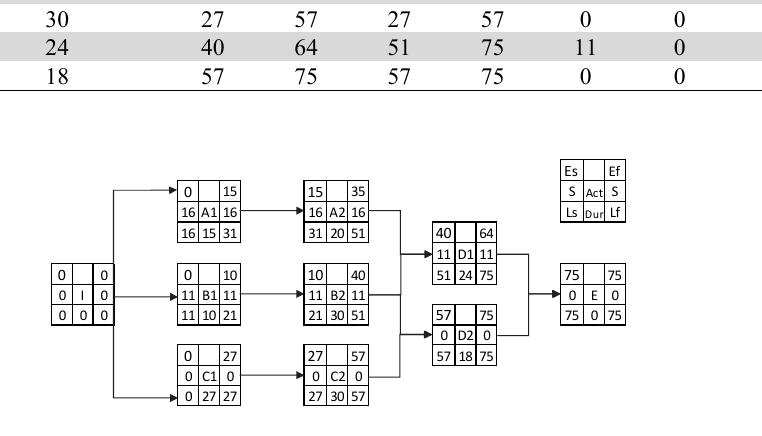
Fig. 3. Project network for problem